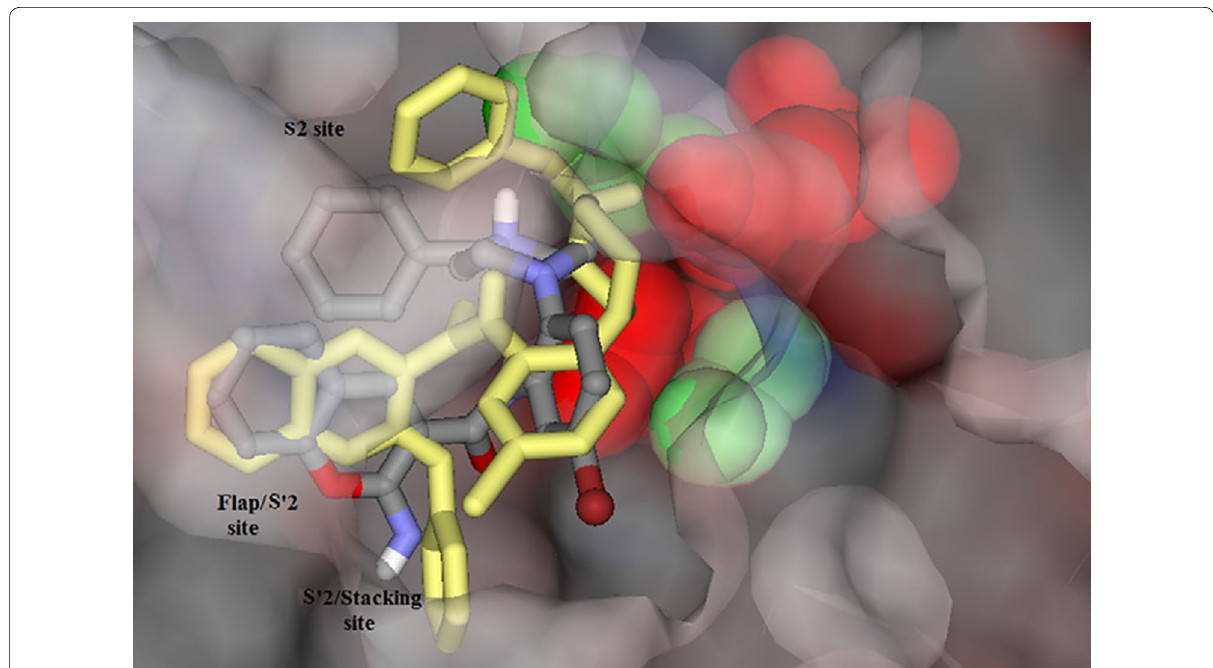
Fig. 77 The comparative binding affinities of benzylpiperazine derivative imino-2H-chromene-3-carboxamide C89a and its Phenylimino-2H-chro men-3-carboxamide analogue C90a [105]